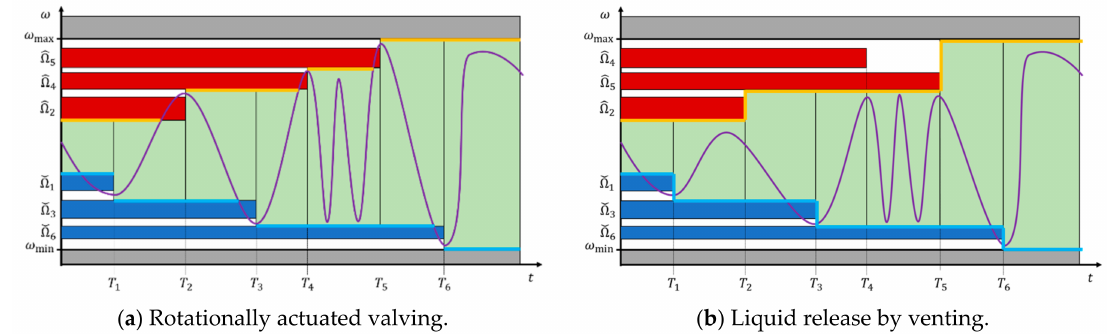
Figure 3. Multiplexing of concurrently loaded valves in frequency vs. time domain. High- and low-pass valving takes place at points in time { T i } . With each step i , a certain frequency corridor (green) that is available for LUOs rearranges. ( a ) For rotational actuation, reliable opening of valves { i , j } in a given step i is triggered by fully crossing their linked frequency bands { Ω i , j ± M · ∆Ω i , j } . ( b ) In venting mode, the concurrently loaded valves serially release according to the order of opening their compression chamber, i.e., V C,0, i (cid:55)→ ∞ and p V (cid:55)→ p 0